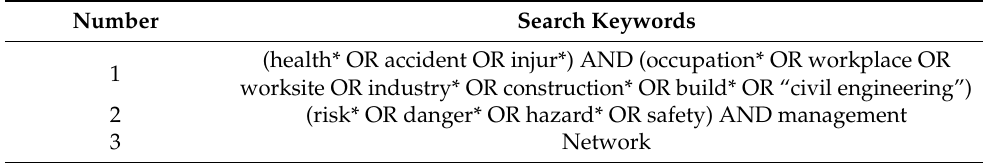
Table 1. List of search keywords used in Web of